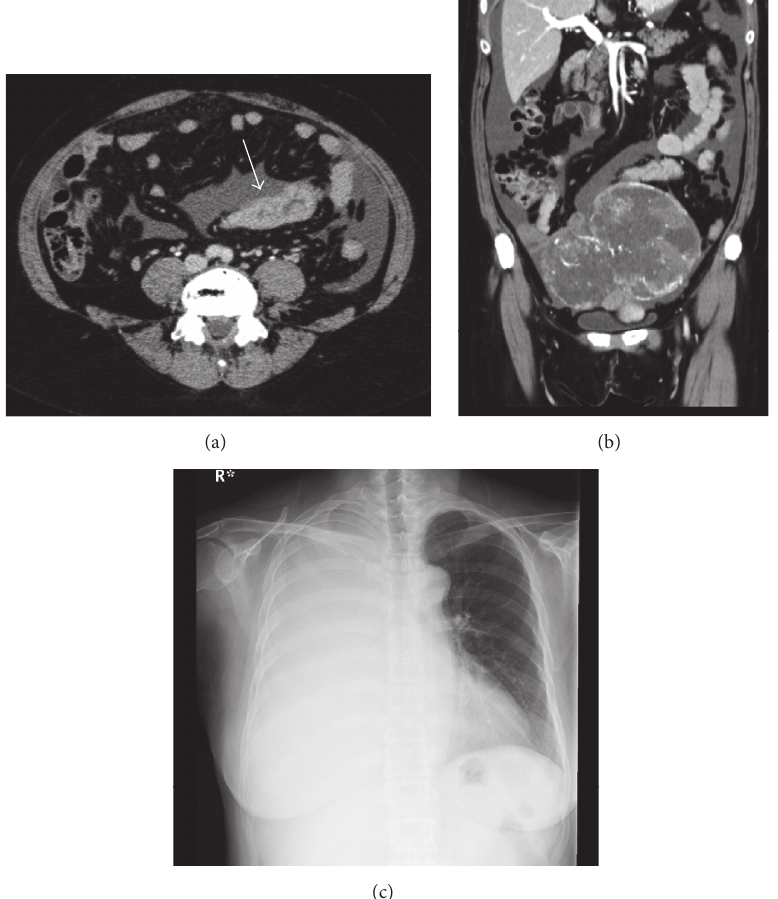
Figure 1: Case 1. Contrast-enhanced CT scan shows wall thickening of the sigmoid colon with enhancement (arrow; (a) axial plane) and a well-circumscribed and heterogeneously enhanced tumor of the ovary ((b) coronal plane). Chest X-ray shows a massive pleural effusion in right thorax (c).